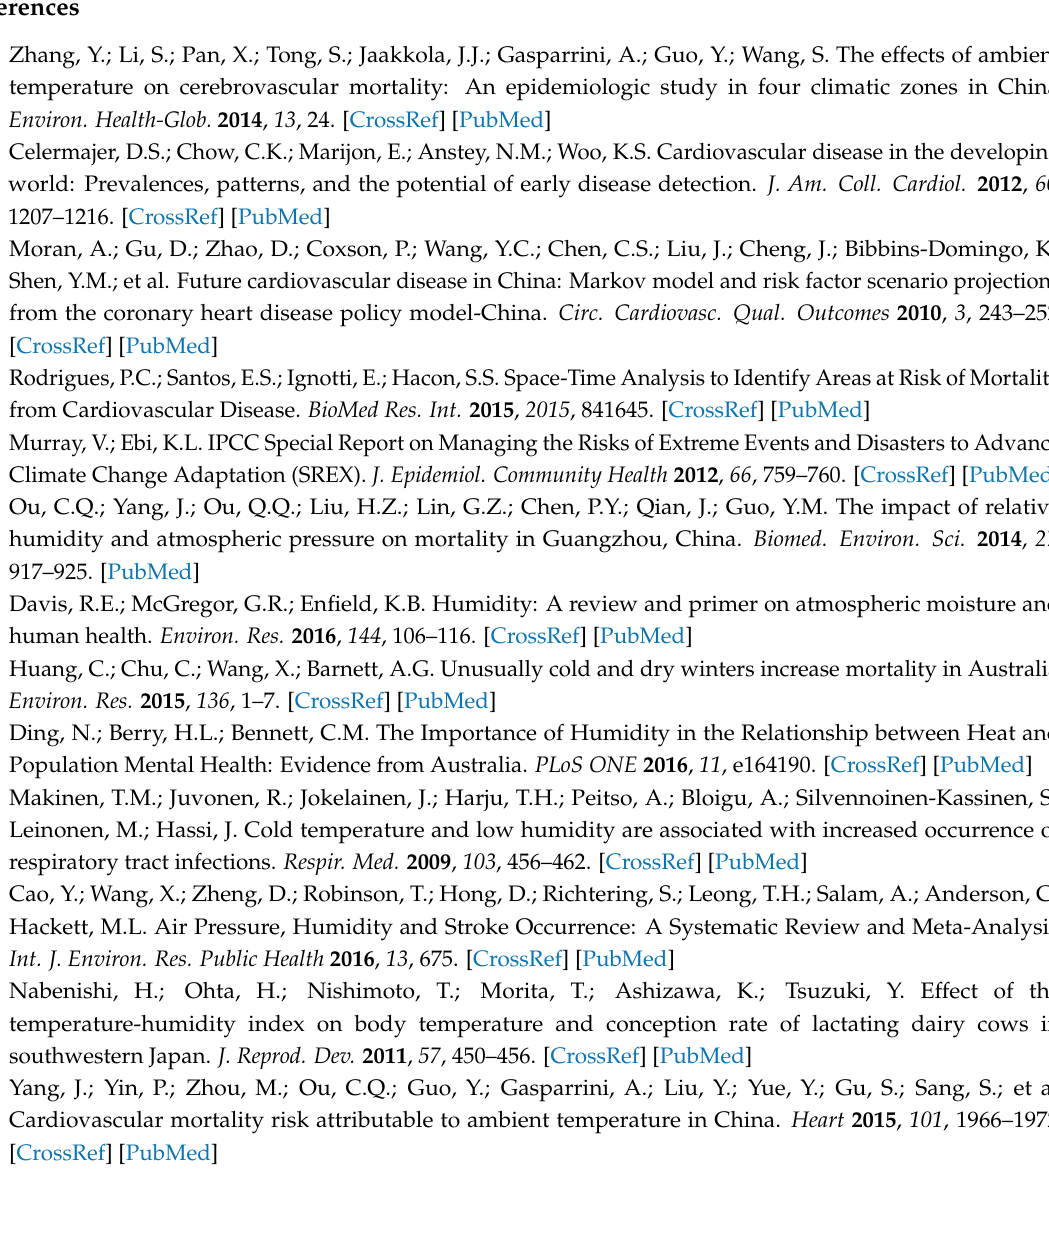
Figure S2: The lag-response relation associated with hot temperatures (97.5th percentile versus minimum-mortality temperature) over lag 0–21 days on CVD mortality in 11 cities of Zhejiang province; Figure S3: The residual variation scatter plots over time for main model in daily deaths after controlling seasonal and long-term trend of 11 cities in Zhejiang